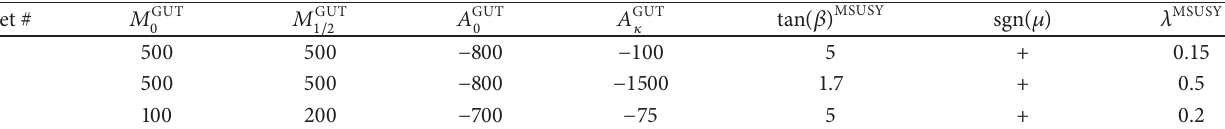
Table 1: Parameter values for studies in case of the constrained NMSSM ( 𝑀 𝑖 and 𝐴 𝑖 in GeV). These sets are inspired by the ranges given in Figures 1–3 of [15].